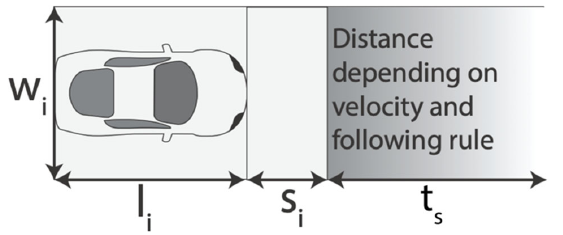
Figure 5. Specifications of the simulation (source: adapted from [13]).